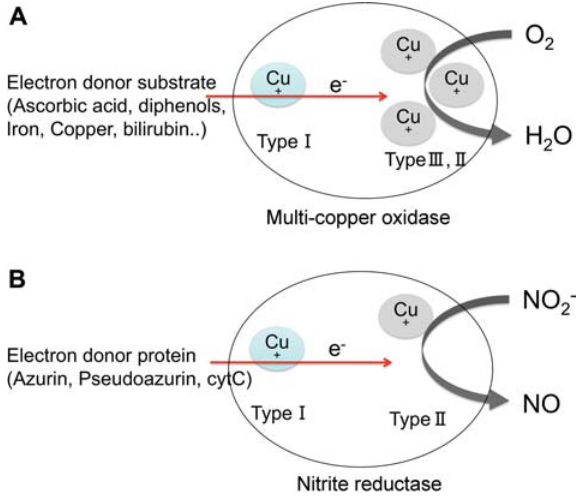
Figure 1 Schematic presentation of the catalytic mechanism of multicopper oxidase (A) and nitrite reductase (B).